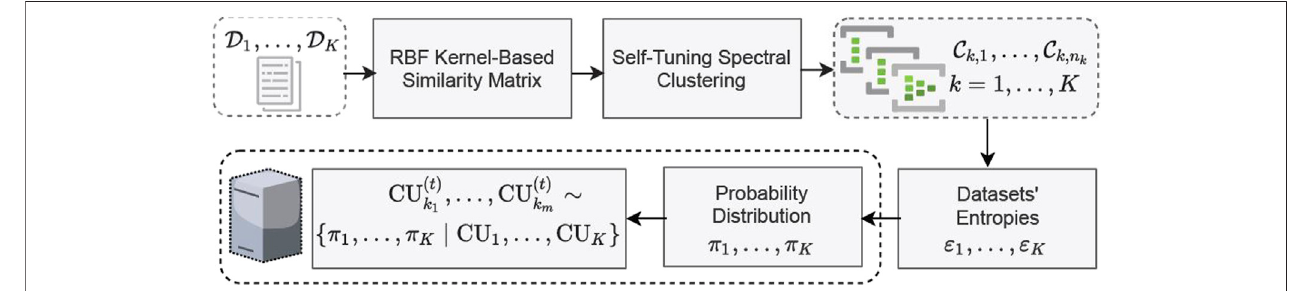
FIGURE 2 | Entropy-driven stochastic federated learning policy.